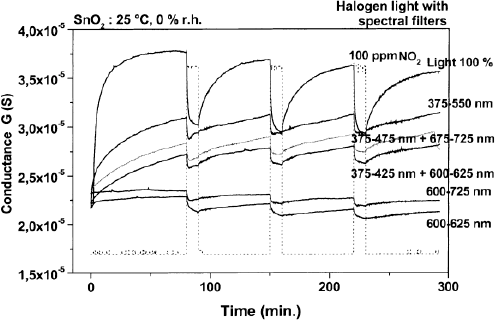
Figure 13. Conductance response of SnO 2 towards 100 ppm NO 2 under different light intensities. Reproduced with permission from [50]. Micromachines 2017 , 8 , 333